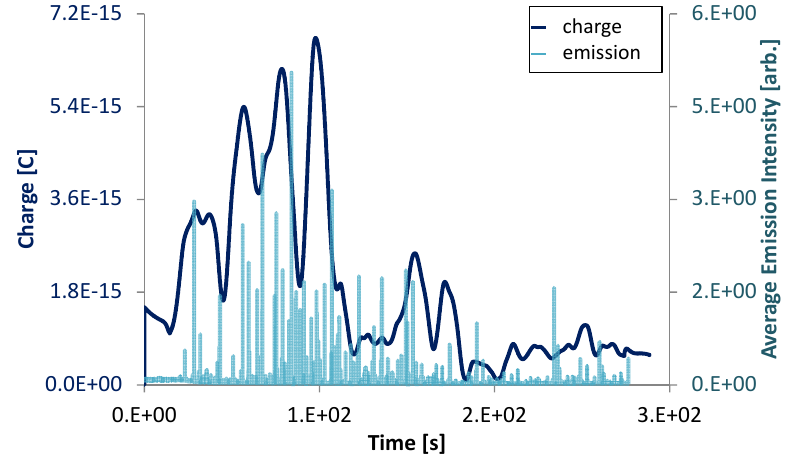
Figure 7. Instantaneous values of average phosphor screen intensity and surface charge vs. time.